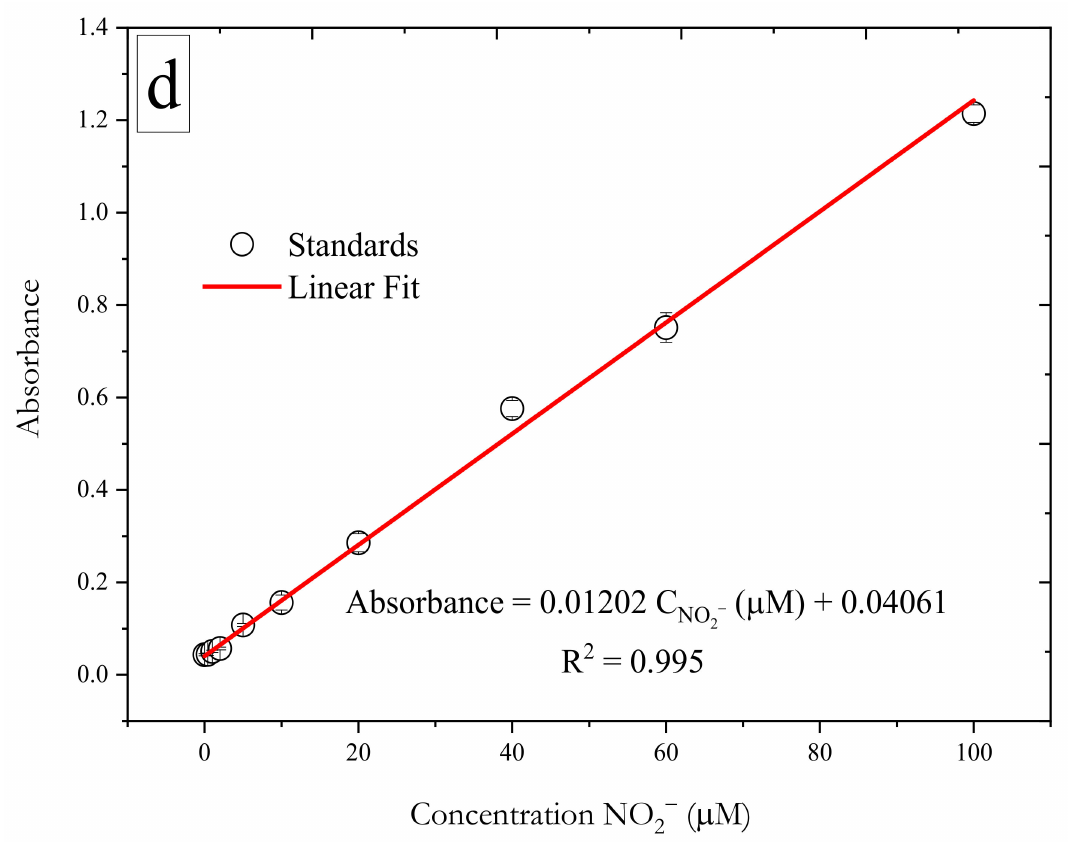
Figure 6. ( a ) Calibration curve for PO 43 − standards (0, 0.2, 0.5, 0.75, 1, 2, 5, 10, 20, 40, 60, and 100 µ M) in a 1 cm flow cell. ( b ) Calibration curve for H 4 SiO 4 standards (0, 0.2, 0.5, 0.75, 1, 2, 5, 10, 20, 40, 60, 100 µ M) into a 2 cm flow cell. ( c ) Calibration for NO 3 − standards (0, 0.5, 1, 2, 5, 10, 20, 40, 60, 100 µ M) into a 1 cm flow cell. ( d ) Calibration curve for NO 2 − standards (0, 0.4, 1, 2, 5, 10, 20, 40, 60, 100 µ M) into a 1 cm flow cell. Blue stars indicate the absorbance of the Kanso CRM CG. Error bar ( ± 1 SD), n =